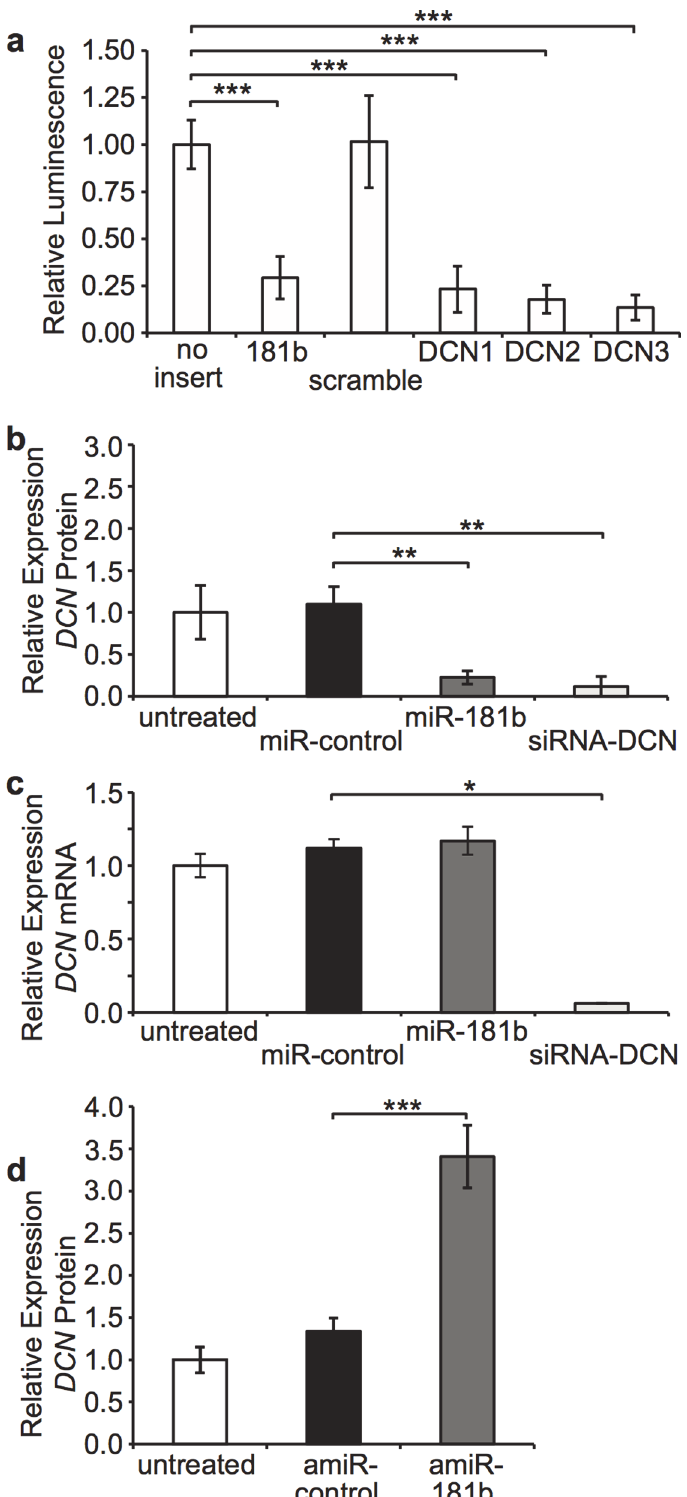
Fig 5. Regulation of DCN by miR-181b. HEK293A were cultured in DMEM + 2% FBS and transfected with pmirGLO constructs containing various miRNA binding sites and (a) relative fluorescence quantitated using a luminometer to determine relative knockdown by miR-181b (mean ± SEM, n = 4, *** P (cid:3) 0.01). SF were